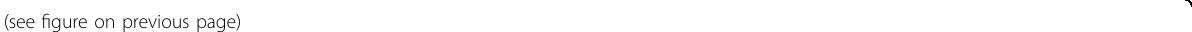
Fig. 6 p62 knockdown reverses the inhibitory effect of XPO1 inhibitor KPT-8602 on KSHV lytic replication but has no effect on virus infectivity, and entry and traf fi cking during primary infection. A HUVEC were infected with lentiviruses expressing shRNAs targeting p62 (shp62- 1 and shp62-2) or a control shRNA (shCtrl). Cells were selected with puromycin (1 µg/ml) for 48 h and analyzed by Western-blotting to monitor the knockdown ef fi ciencies. β -actin served as the loading control. B HUVEC with p62 knockdown were pretreated with 0.5 µM KPT-8602. Cells infected with KSHV for 48 h in the presence of KPT-8602 (0.5 µM) were fi xed and stained for LANA (red). The expression level and staining pattern of LANA protein are shown. Nuclei were stained with DAPI. Images were taken with a confocal microscopy (magni fi cation ×600). C Quanti fi cation of LANA- positive cells using images taken as described in ( B ). D HUVEC with p62 knockdown were pretreated with 0.5 µM KPT-8602 for 1 h, and then infected with KSHV in the presence of KPT-8602 (0.5 µM) for 6 h. Cells were fi xed and stained for nuclei with DAPI (blue) and KSHV particles with an antibody to ORF65 (red). Images were taken with a confocal microscopy (magni fi cation ×1000). E The total number of KSHV particles successfully docked at the perinuclear region of each nucleus was quanti fi ed and analyzed based on images taken as described in ( D ). F – I HUVEC with p62 knockdown was pretreated with 0.5 µM KPT-8602 for 1 h and then infected with KSHV in the presence of KPT-8602 (0.5 µM). Cells were collected for RNA extraction at 48 hpi and examined for the expression of KSHV genes including RTA ( F ), ORF57 ( G ), ORF65 ( H ), and LANA ( I ) by RT-qPCR. J HUVEC with p62 knockdown were pretreated with 0.5 µM KPT-8602 for 1 h and then infected with KSHV for 48 h in the presence of KPT-8602 (0.5 µM). Cell lysate was collected and analyzed for the expression of p62 and KSHV proteins by Western-blotting. β -actin served as the loading control. *, **, and *** indicate